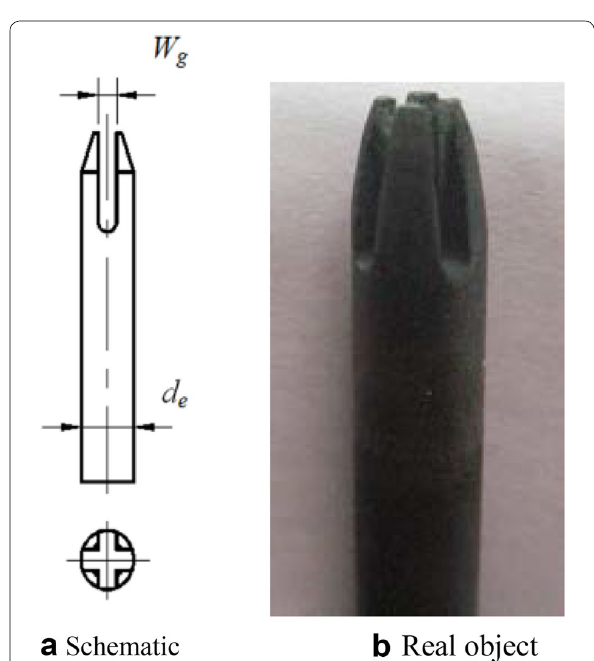
Figure 2 Coupling arc